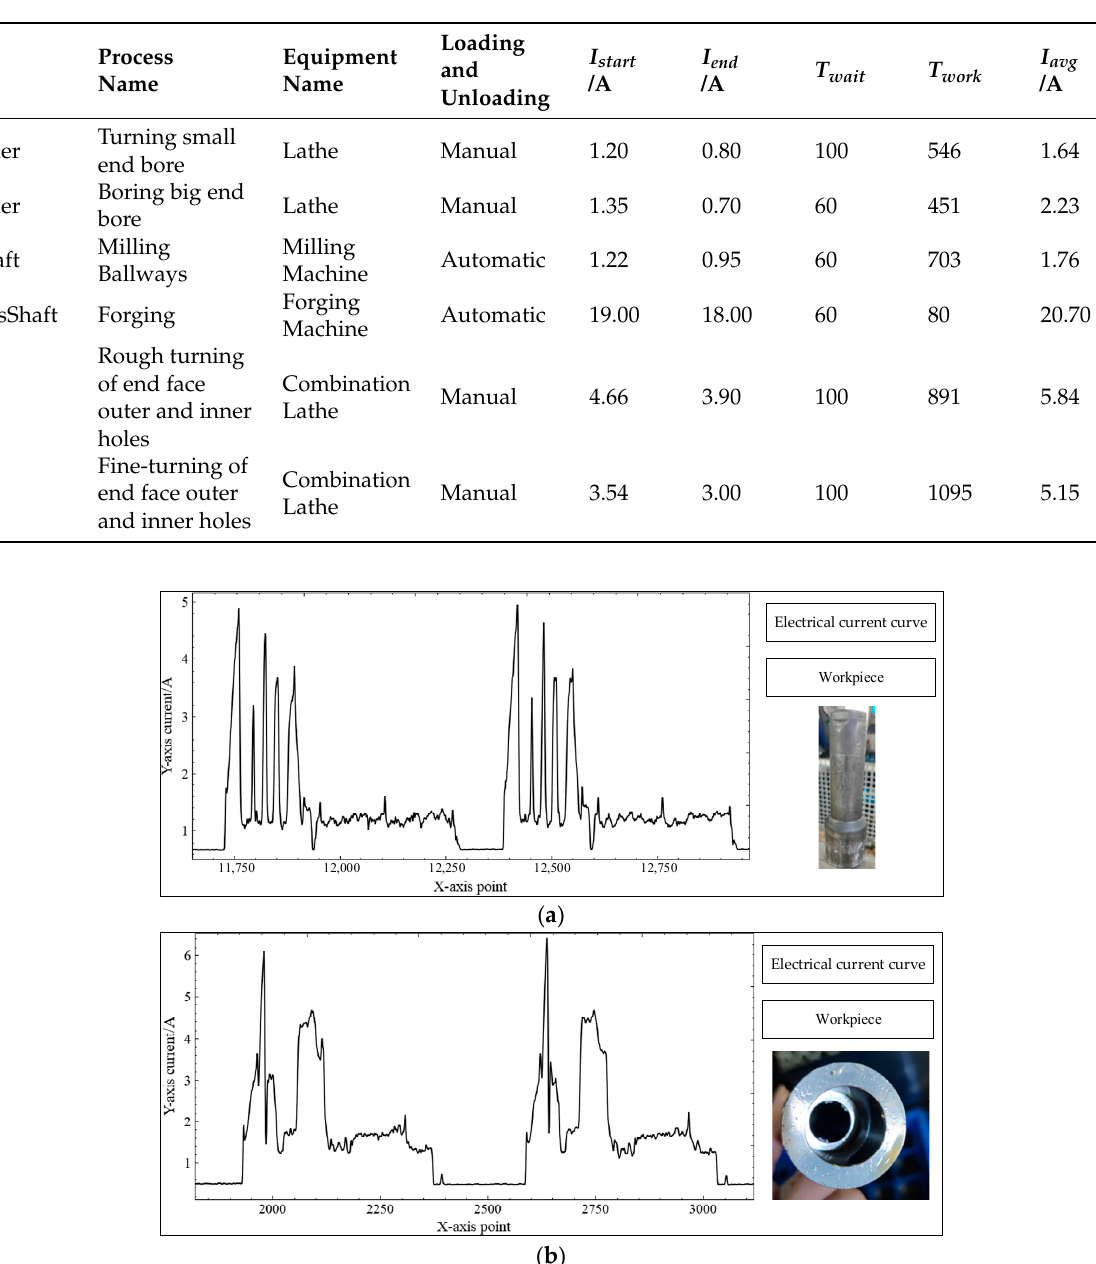
Table 1. Part calibration.